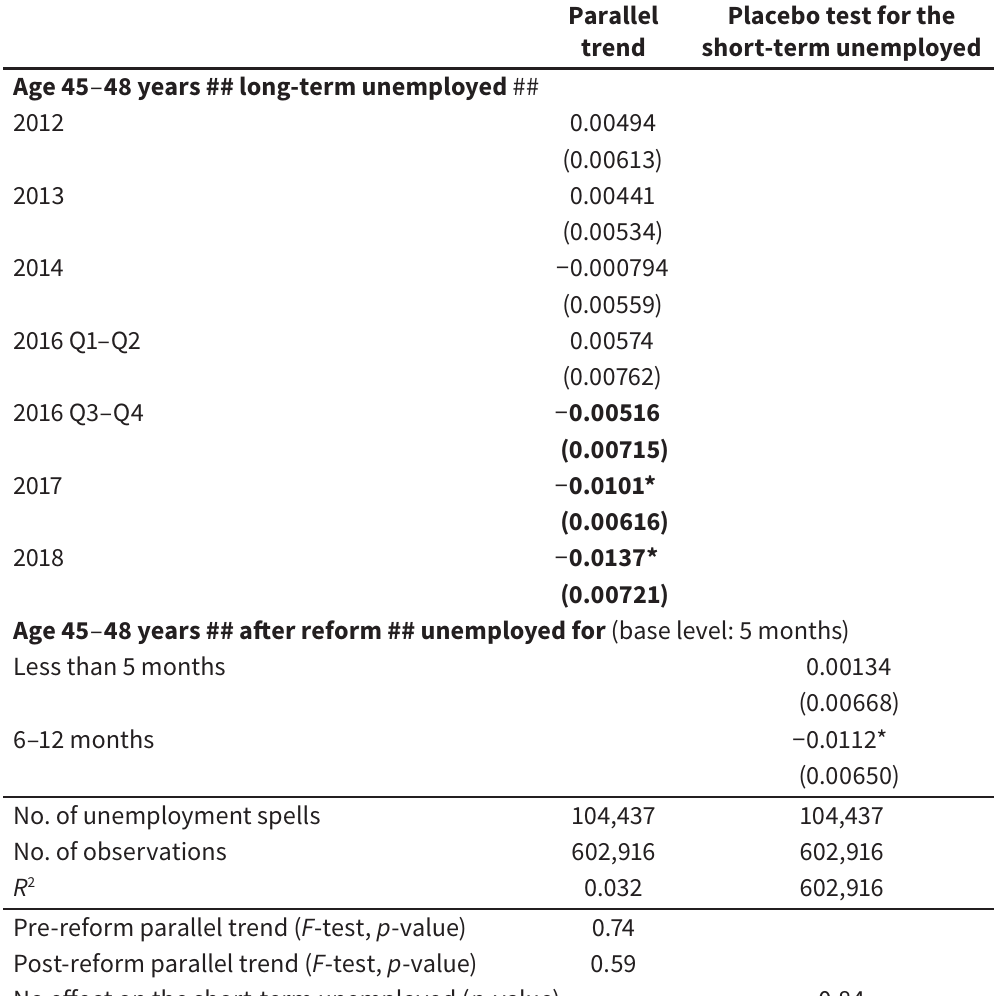
Placebo tests for the benchmark analysis